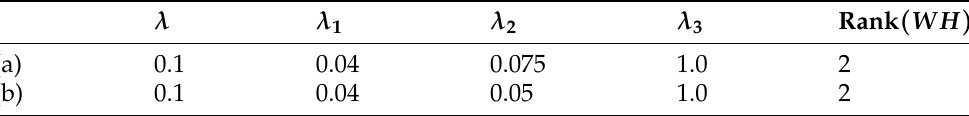
Table 2. Hyperparameters of the proposed methods automatic segmentation (a), segmentation with windowing (b) for muscle detection and valve segmentation algorithms.